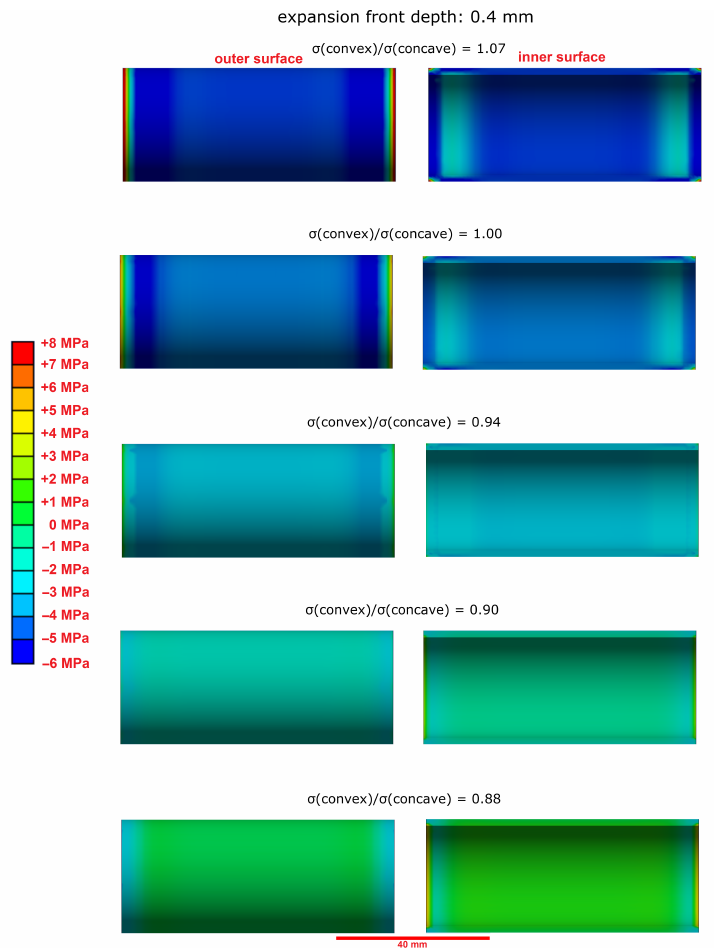
Figure 14. Modelled stress distribution (finite element model, first main tension) in the undamaged in- ner core over the length of a hollow cylinder that is exposed to expansion stress ( σ (concave) = 8.0MPa). ( Left ): at the outer surface, ( Right ): at the inner surface of the cylinder. The expansion front depth of the ettringite formation is 0.4mm. The tensile strength of the samples inner core is not exceeded for this expansion front